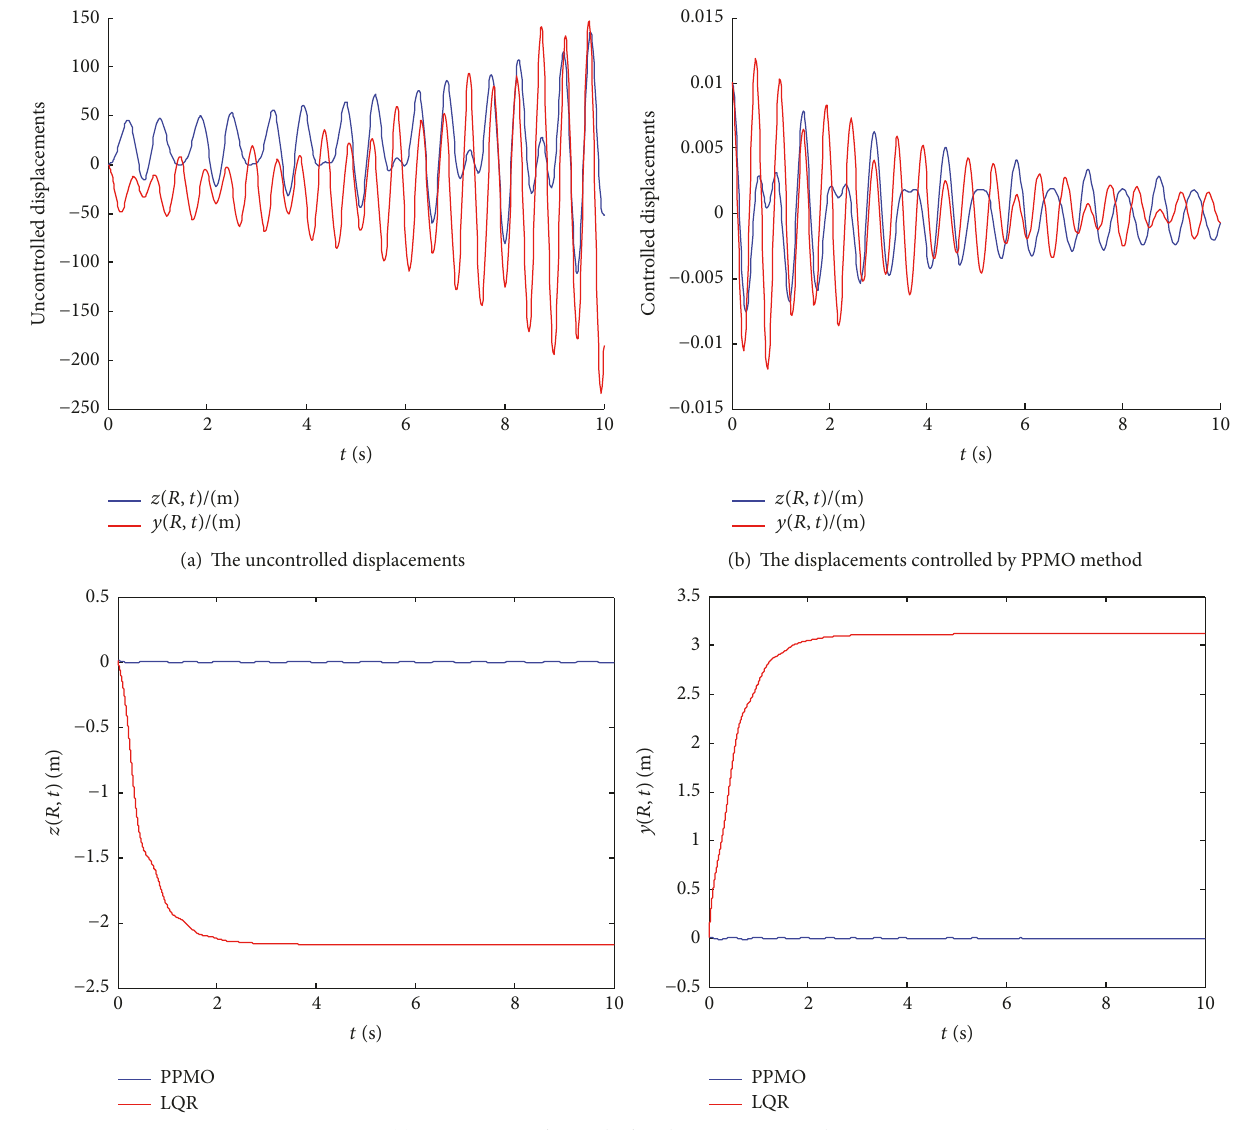
Figure 6: The uncontrolled displacements (a) and those controlled by PPMO (b) under the condition of wind speed of 𝑈 = 20 m/s, with comparisons of control effects between PPMO and LQR demonstrated in